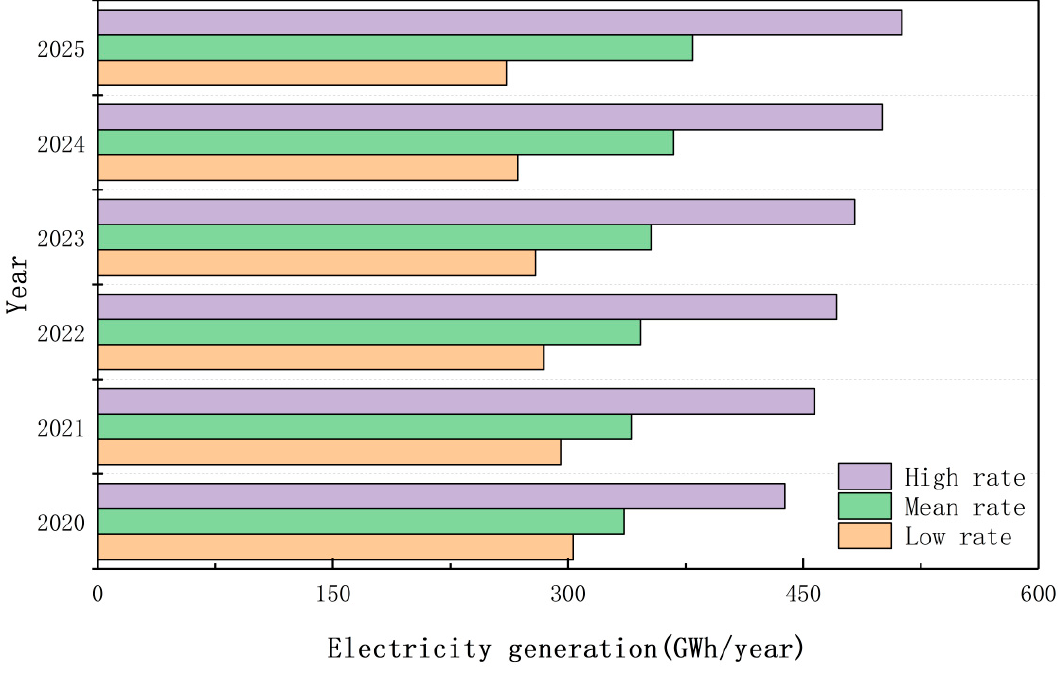
Figure 5. MSW electricity generation under different scenarios.